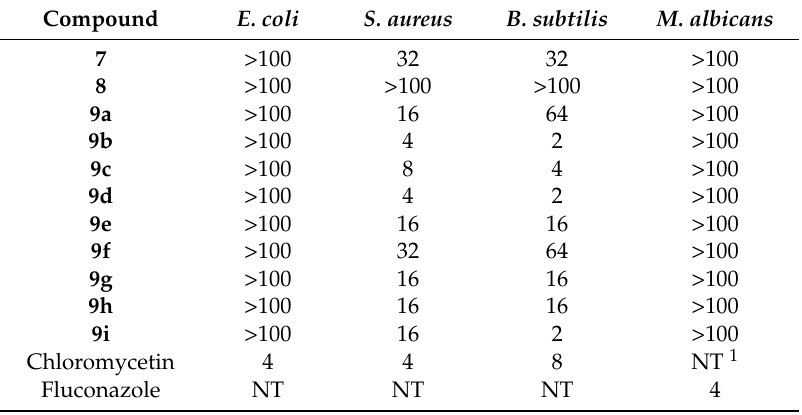
Table 1. The antimicrobial activity of the synthesized compounds (MIC μ g/mL). Compound